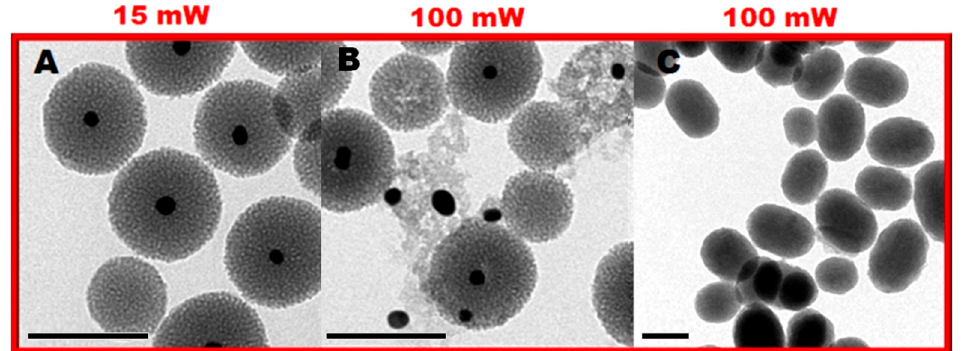
Figure 3. TEM images of Au@MSN irradiated 14 h at 514 nm under 15 mW ( A ), and 100 mW ( B ) displaying the power dependency of PT effect. Intact bare mesoporous silica NPs after irradiation for